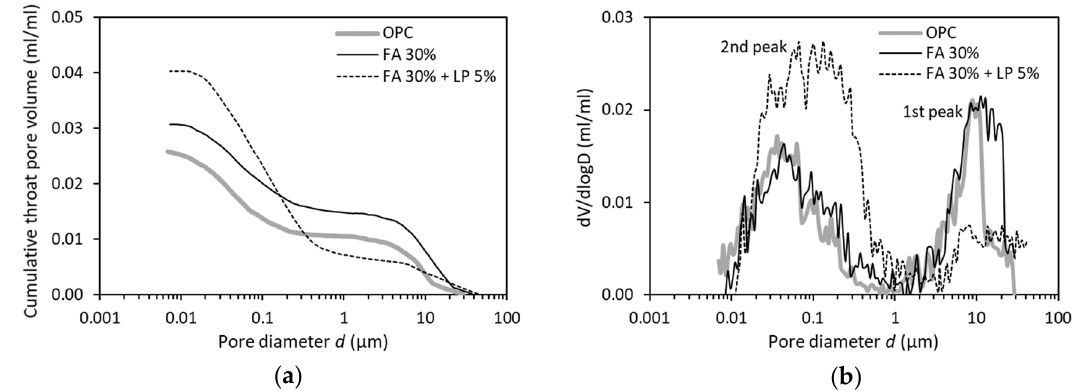
Figure 8. E ff ect of fly ash and / or LP on ( a ) distribution of throat pores and ( b ) di ff erential curves in paste specimens (w / b = 0.5, 28 days).